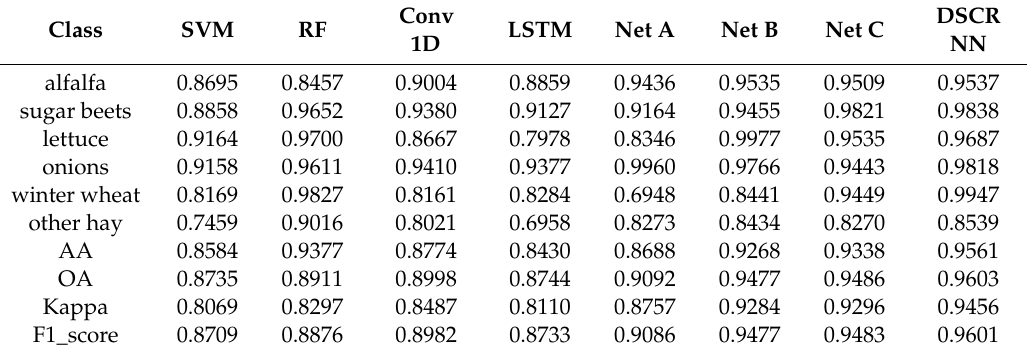
Table 4. Results of study area 1.